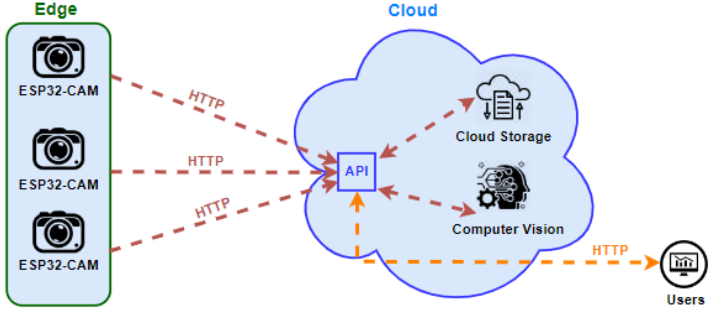
Figure 6. Proposed IoT